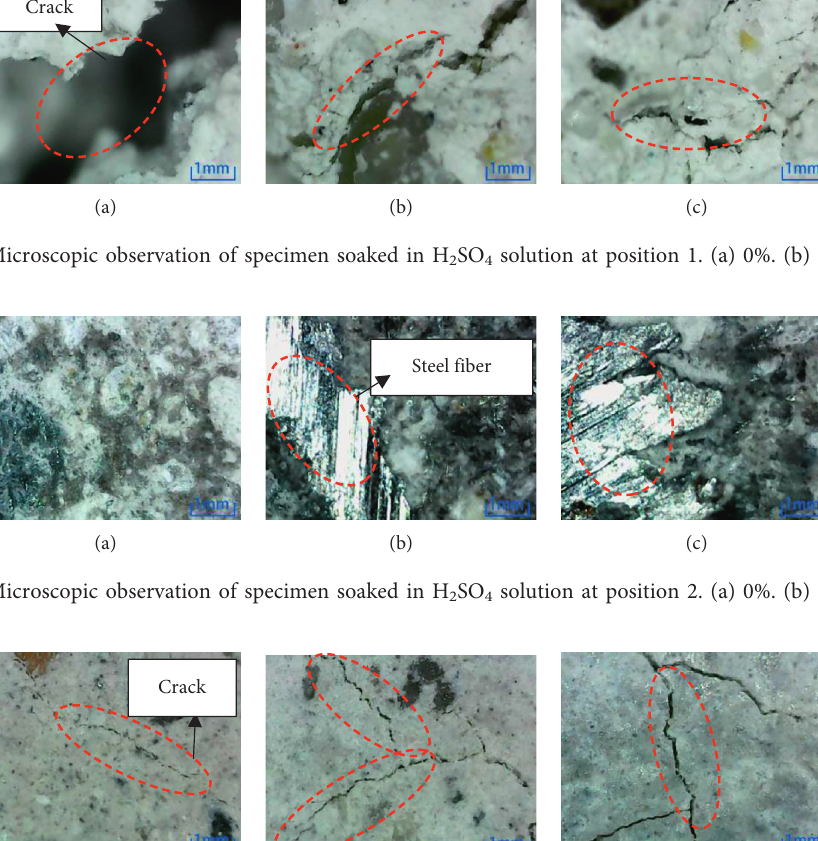
2 SO 4 solution at position 2. (a) 0%. (b) 1%. (c)